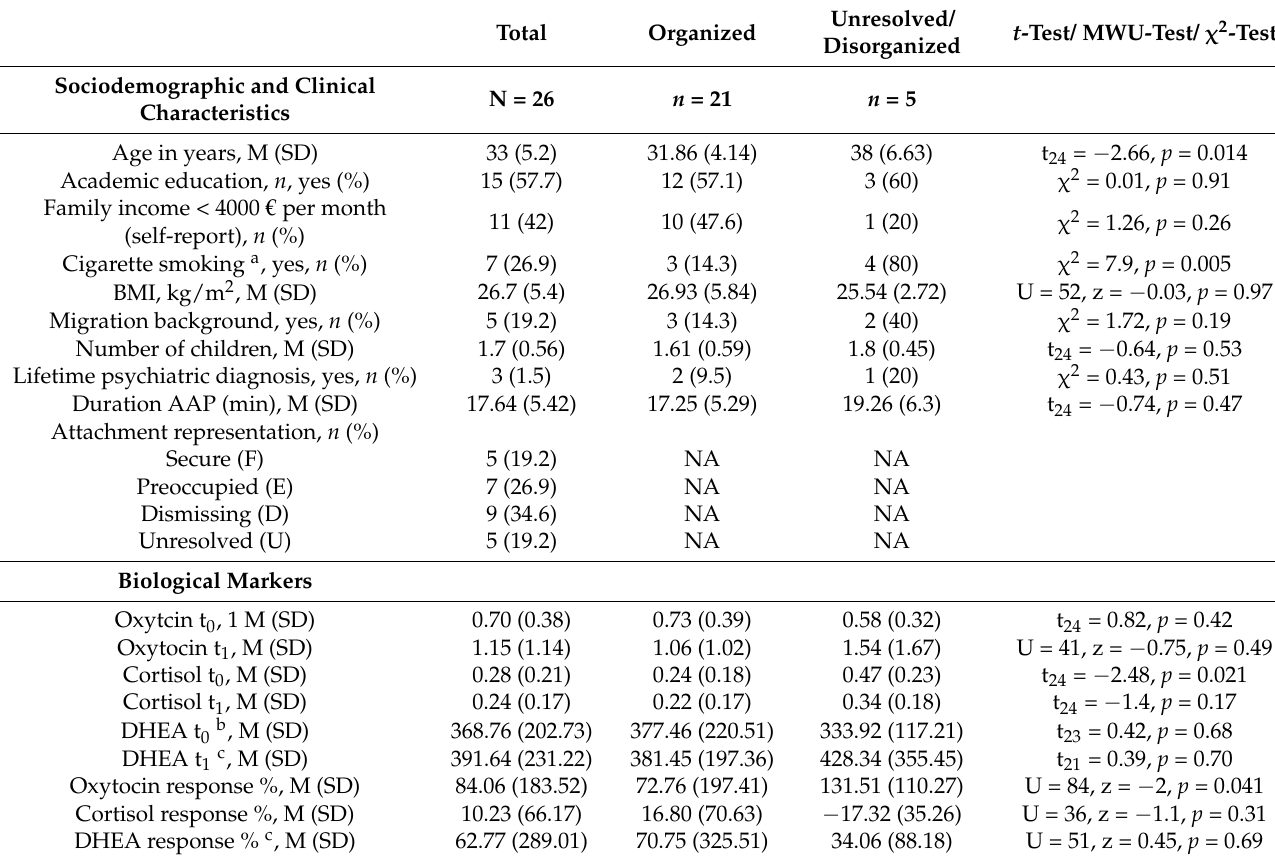
Table 1. Sociodemographic, clinical characteristics and salivary biomarker results of the participants for the total cohort and separately for fathers with an organized and disorganized attachment representation according to the AAP classification. Differences between the organized and the disorganized/unresolved group were calculated using independent t -test (normally distributed data), Mann–Whitney U test (non-normally distributed data), or χ 2 -test (binary variables). Unresolved/ Total Organized t -Test/ MWU-Test/ χ 2 Disorganized